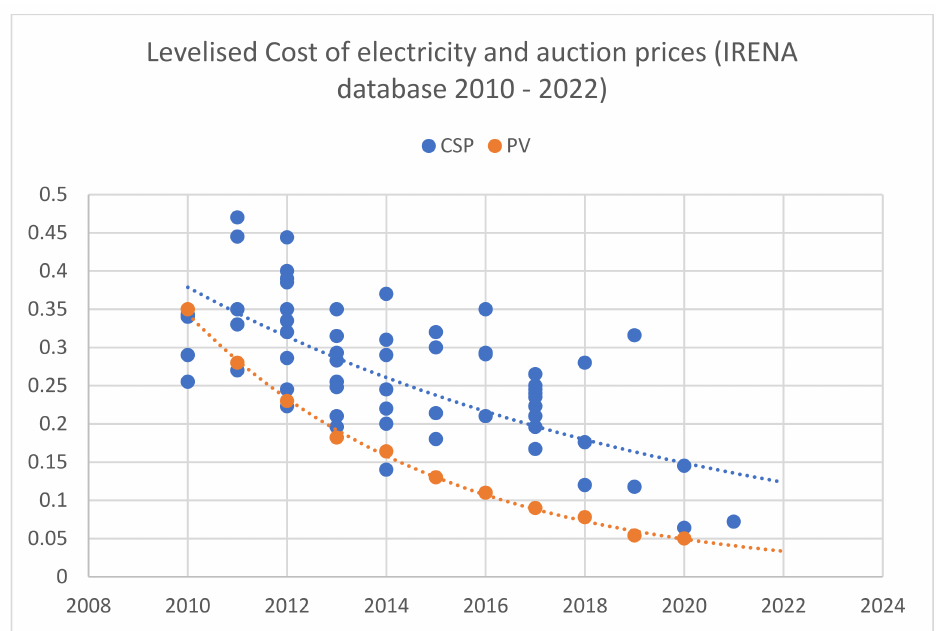
Figure 3. Authors own derived from IRENA database